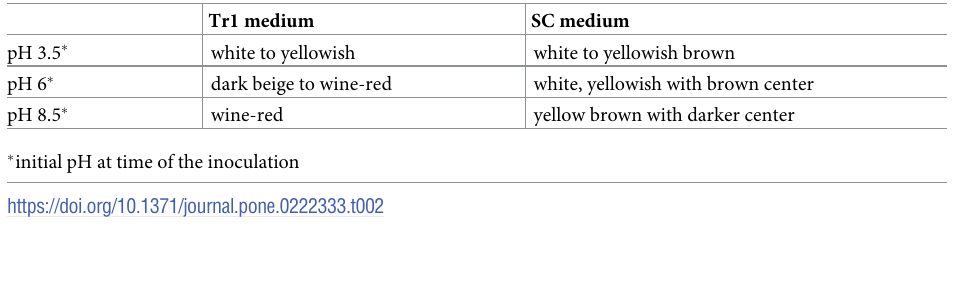
Table 2. Overview of the pigment color of the T . rubrum grown on two different media for four